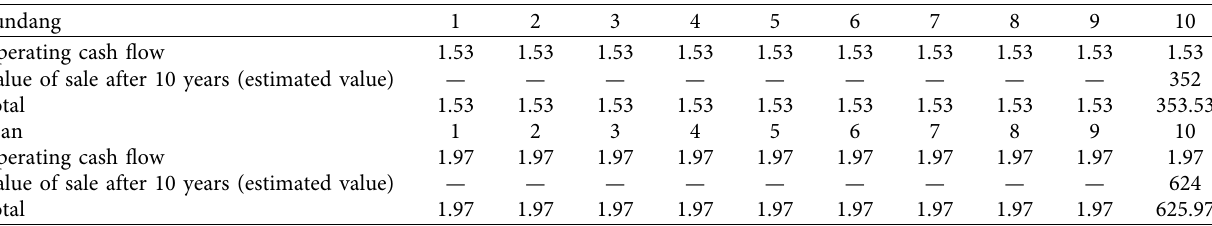
Table 2: Estimate cash flow by year of the public sports centers in Bundang and Ilsan (as of 2020; unit: KRW 1 million). Bundang